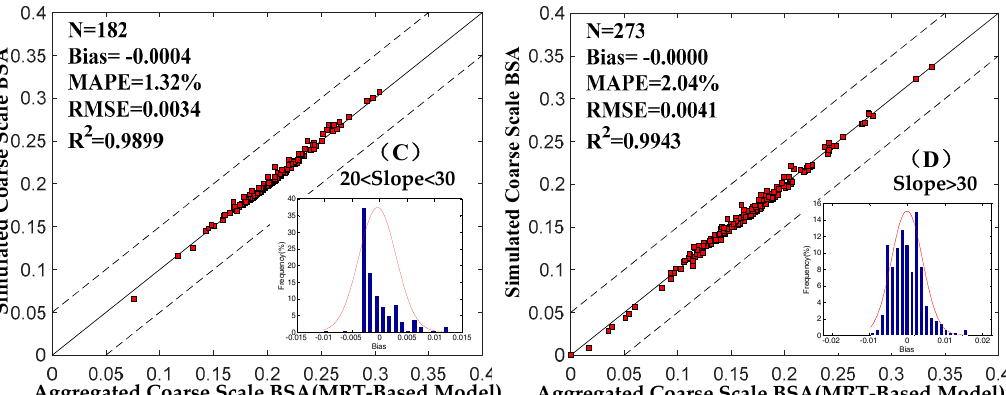
Figure 7. Validation of the MRT-based upscaling model at different slopes ( A ) the slope is smaller than 10 degree; ( B ) the slope is greater than 10 degree and less than 20 degree; ( C ) the slope is between 20 and 30 degrees; and ( D ) the slope is larger than 30 degrees.